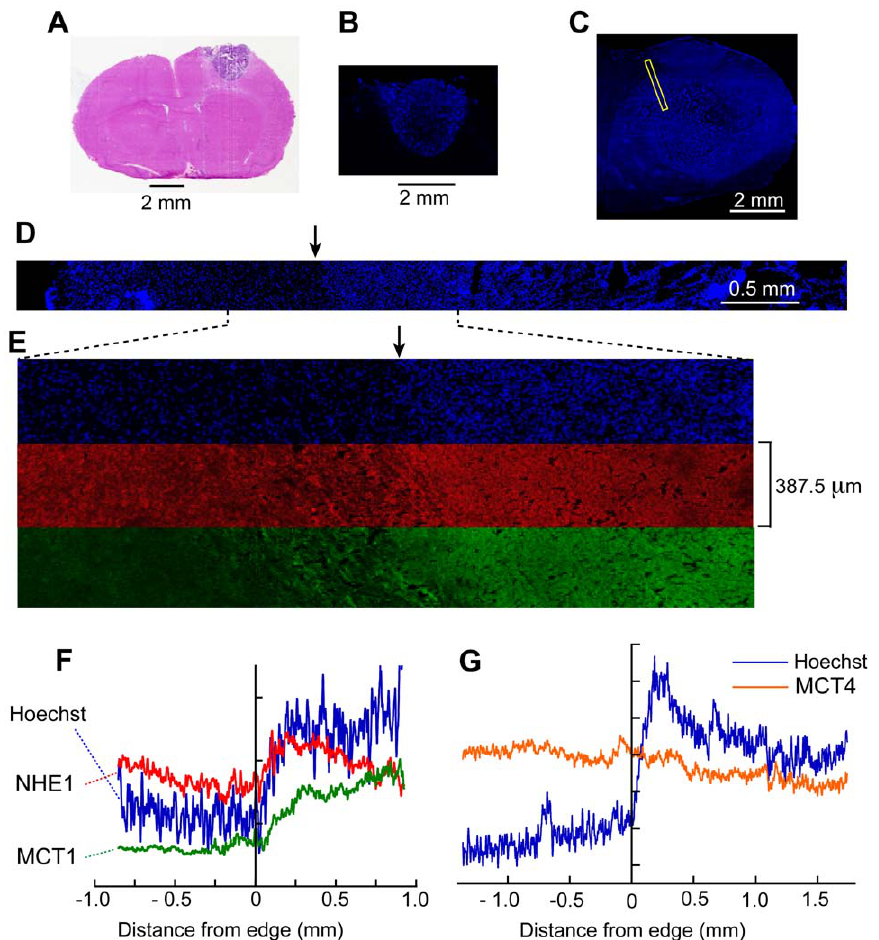
Figure 1. Immunofluorescence profiles across the tumor border. (A) A section of a small C6 glioma stained with haemotoxylin-eosin; (B) part of an adjacent section with nucleic acids stained with Hoechst 33342. (C) Another glioma stained with Hoechst and showing a strip crossing the border that was tilescanned. (D) The Hoechst tilescan of the strip indicated in (C). (E) Portions of the tilescan for Hoechst (blue) NHE1 (red) and MCT1 (green). (F) Intensity profiles of the strips in (E) with positive distances directed into the glioma. From the Hoechst profile, it was possible to identify the approximate position of the tumor border on the micrographs (arrows in D and E). (G) Intensity profiles from another section labeled for MCT4 showing it does not increase markedly in the rim.